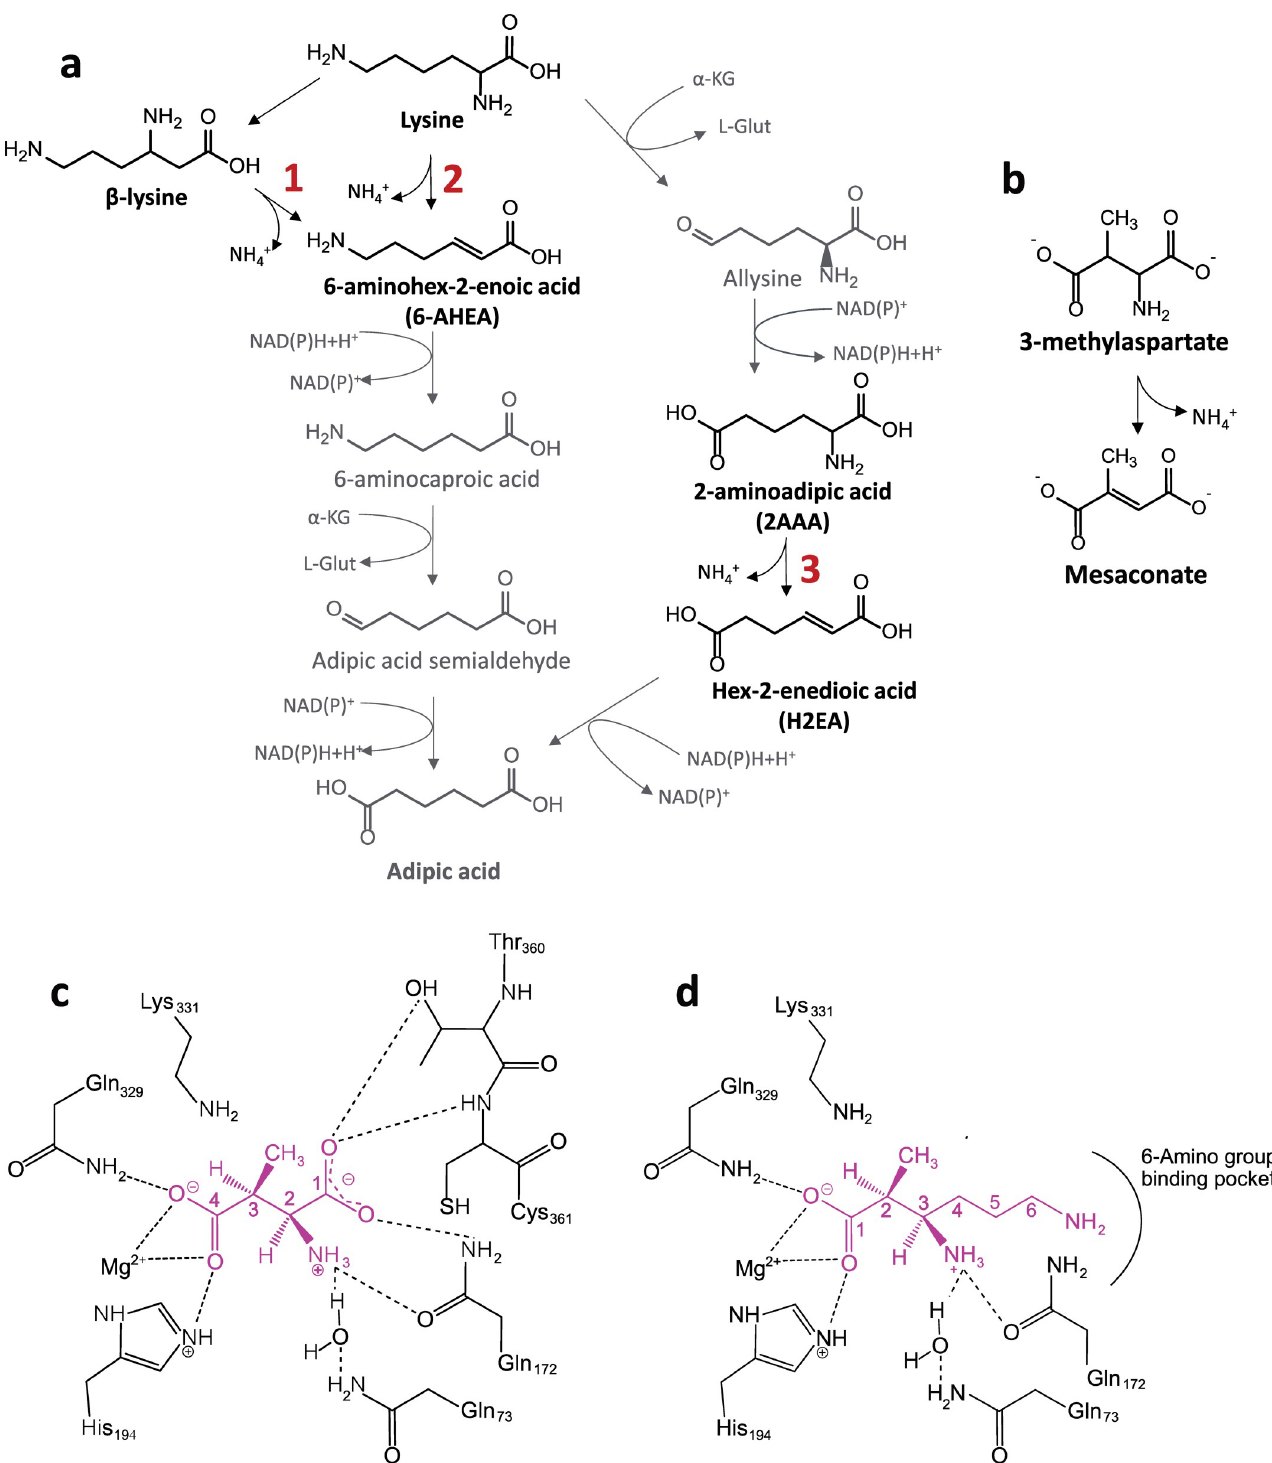
Fig 1. Deamination reactions in metabolic pathways for adipic acid biosynthesis. (a), Metabolic pathway(s) considered for the production of adipic acid from lysine. The three deamination reactions are numbered in red. (b), Reaction catalysed by 3-methylaspartate ammonia lyase (MAL). (c), Schematic representation of 3-methylaspartate (magenta, with carbon labelling indicated) bound in the CaMAL catalytic pocket (black). Adapted from [14]. (d), Schematic representation of our hypothesis on how β -lysine (magenta, with carbon labelling indicated) would bind in CaMAL catalytic pocket (black).